Question: What does this figure show? Answer in one sentence.
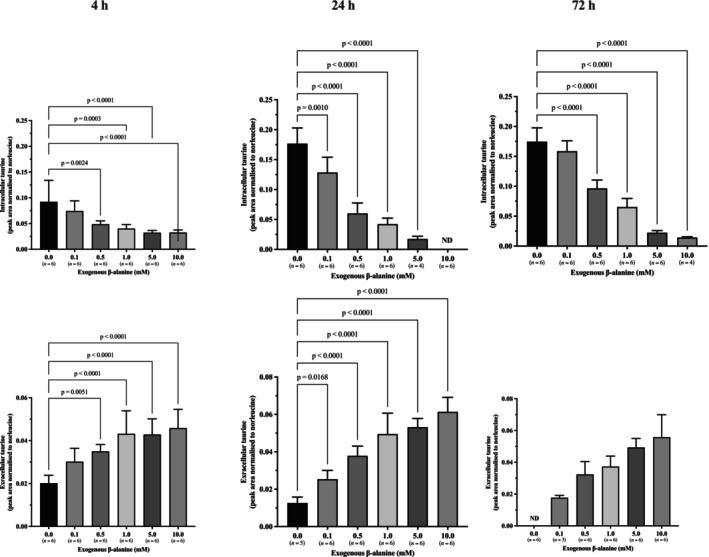
Answer: Intra‐ and extracellular taurine in differentiated H9c2 cardiomyocytes after 4, 24, and 72 h of exogenous β‐alanine incubation. Data are calculated as analyte peak area normalized to the internal standard (Norleucine) peak area and presented as mean ± 1 SD. Replicate numbers included in analysis are presented underneath each respective concentration. Abbreviations: ND, not detected.